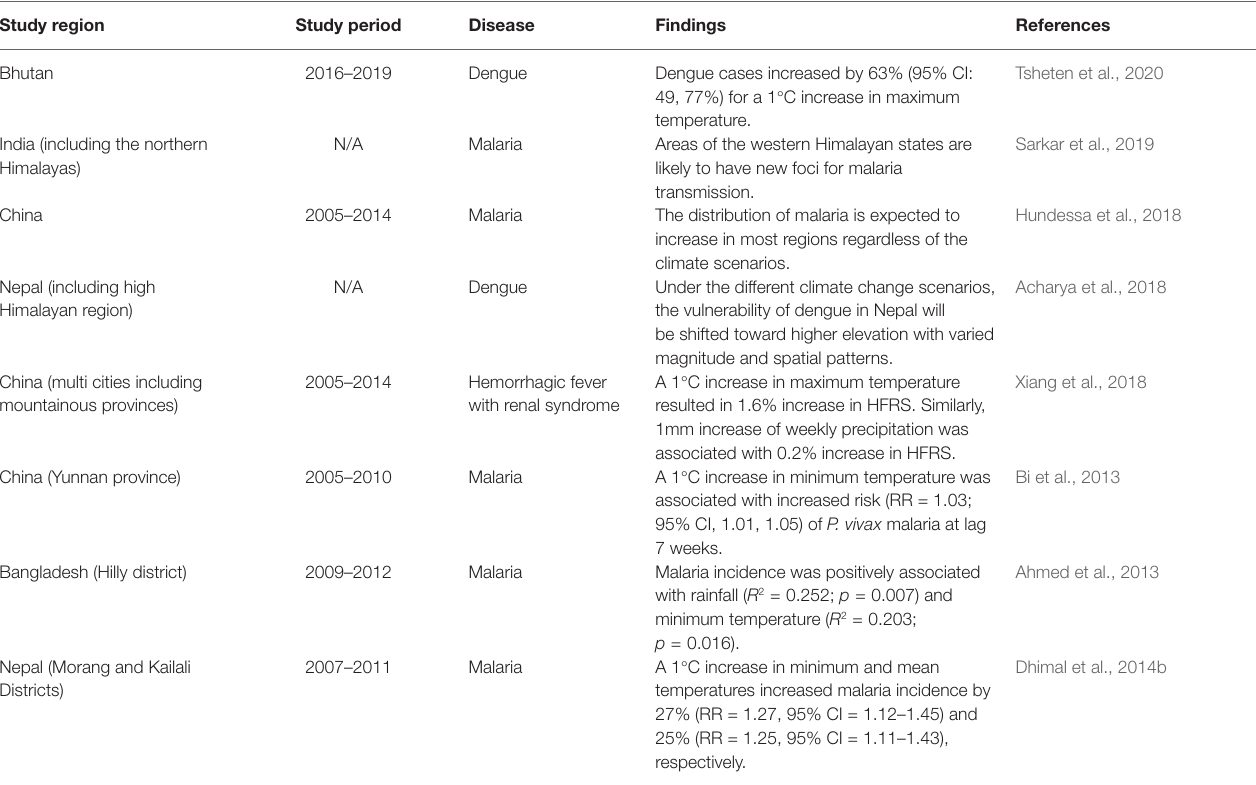
TABLE 1 | Epidemiological evidence on the impacts of climate change on vector borne disease in Hindu Kush Himalayan (HKH). Study